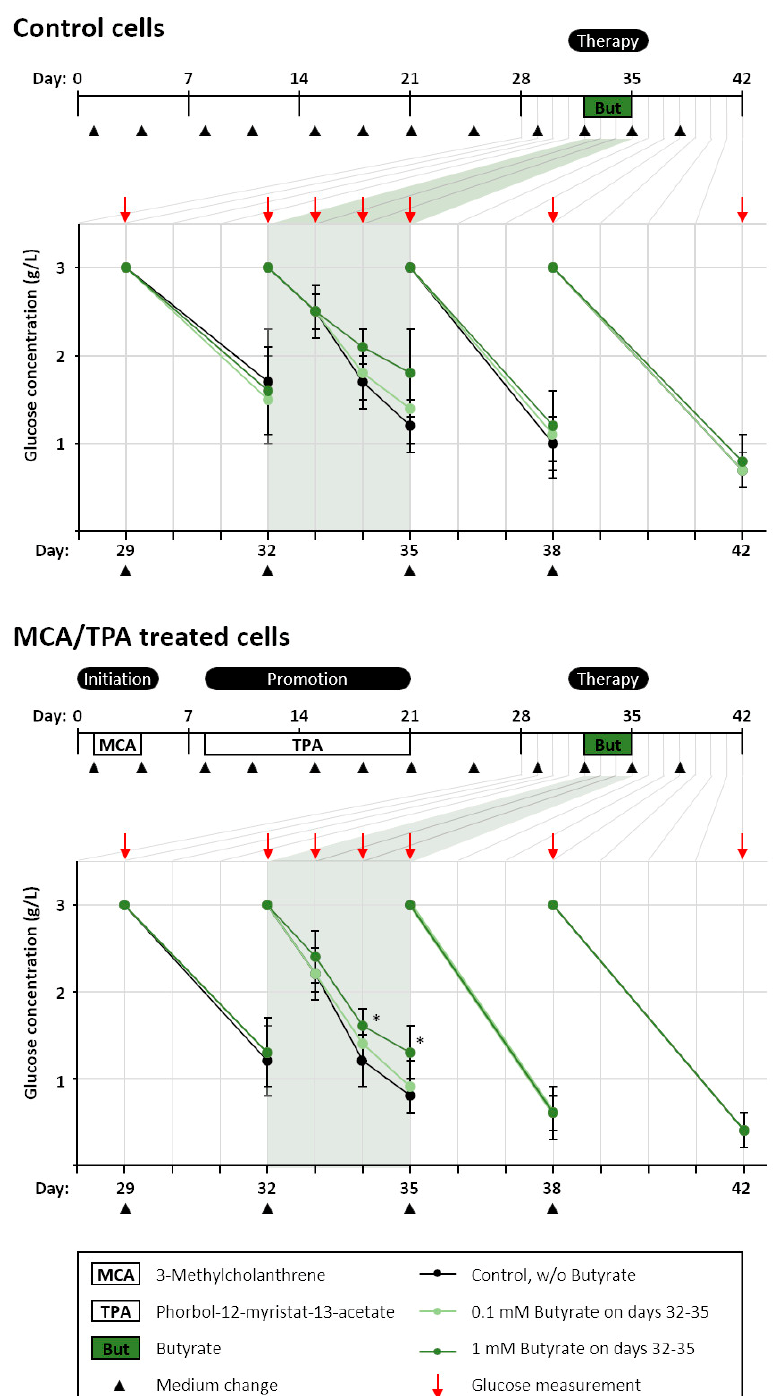
Figure 2. Butyrate alters glucose consumption in the BALB-TTM. The BALB-TTM was performed (see methods). An additional treatment with butyrate was conducted on Days 32–35. On Days 35–42, cells were incubated in medium without butyrate. Control cells were treated with DMSO instead of MCA/TPA. Medium supernatants were collected at Days 32, 33, 34, 35, 38, and 42, and the glucose concentration was measured. The slanting lines indicate a decrease in glucose compared to fresh medium with 3.0 g/L D-glucose, which was replaced every 3–4 days. Statistical differences were calculated from four biological replicates via a one-way ANOVA (post hoc: two-sided Dunnett-T) with * p < 0.05 vs. control for each point in time.